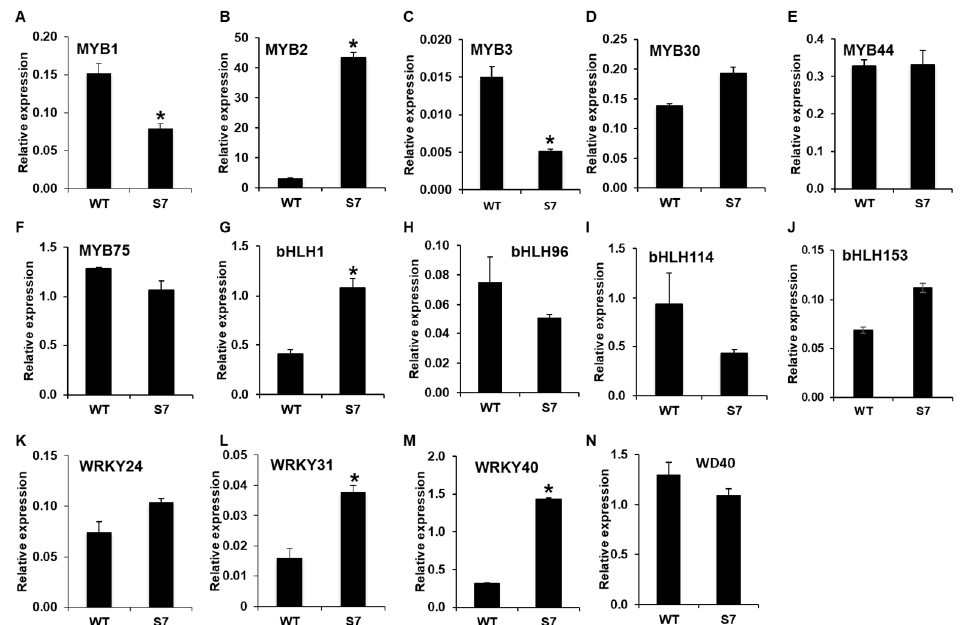
Figure 6. qRT-PCR analysis of 14 genes showing altered expression levels in the RNA-Seq analysis. The relative expression levels of transcription factor genes in the leaves. More specifically, ( A – N ) indicate the relative expression levels of MYB1 , MYB2 , MYB3 , MYB30 , MYB44 , MYB75 , bHLH1 , bHLH96 , bHLH114 , bHLH153 , WRKY24 , WRKY31 , WRKY40 , and WD40 . The EF1a gene served as an internal control. Error bars indicate standard deviations ( n = 3). The error bars indicate SD ( n = 3). Results are representative of two independent experiments. Asterisks denote a significant difference between respective WT and RB016-S7 mutant leaves samples ( t -test, p < 0.0001).